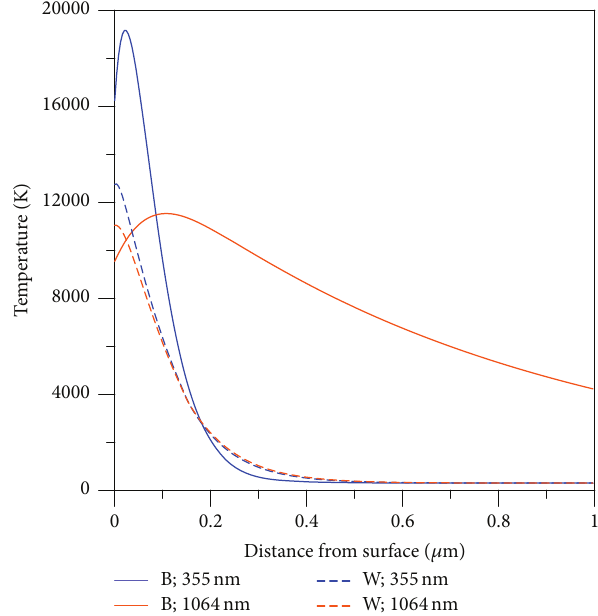
Figure 3: Target temperature 𝑇 and laser intensity 𝐼 𝐿 along target axis at the time moments when the surface temperature reaches its maximum value.